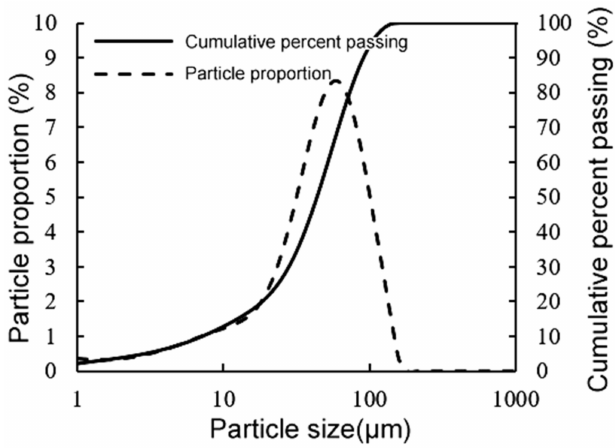
Figure 1. Geographical location of the sampling point.